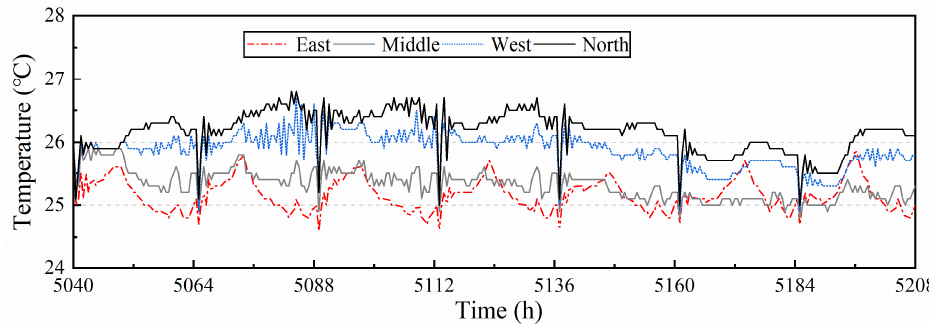
Figure 17. Temperature response with partition demand control.